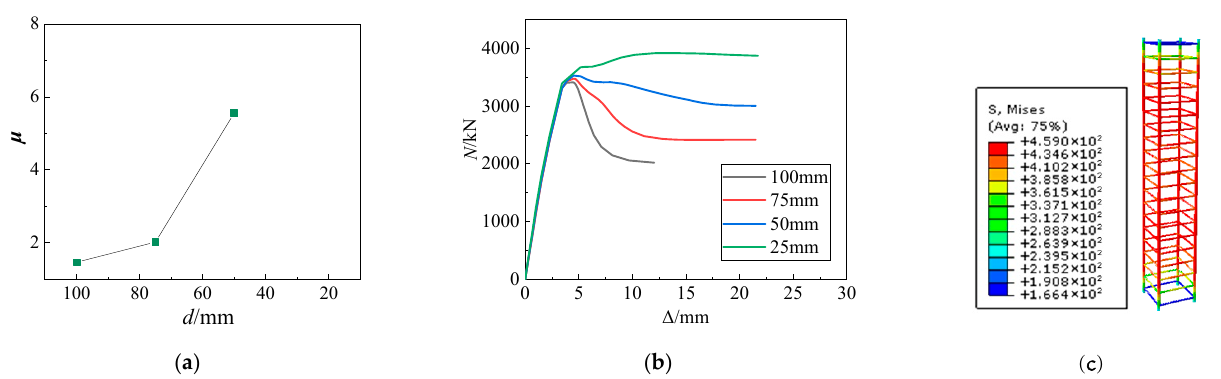
Figure 13. The simulation results at different stirrup spacings: ( a ) the ductility coefficient at different stirrup spacings; ( b ) the N – Δ curves at various stirrup spacings; ( c ) the rebar stress nephogram of specimen S3.